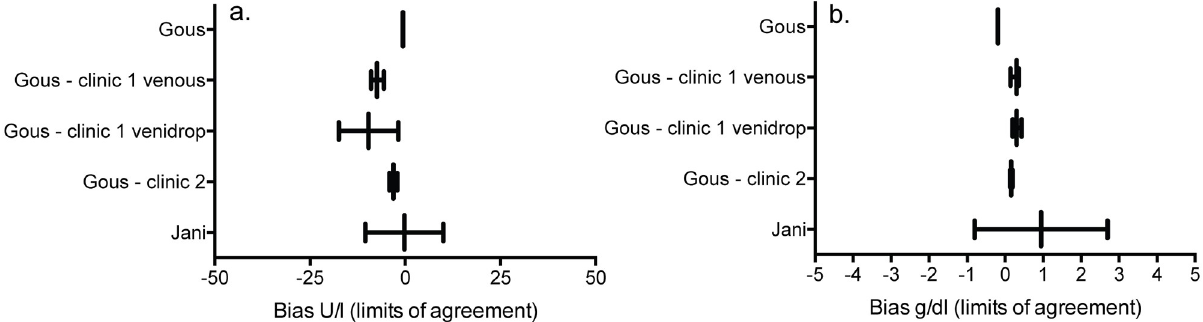
Fig 3. Forest plots of point-of-care ALT and hemoglobin diagnostic accuracy performance by non-laboratory staff. (a) point-of-care ALT testing by non-laboratory staff compared to conventional laboratory-based testing by professional laboratory staff; (b) point-of-care hemoglobin testing by non-laboratory staff compared to conventional laboratory-based testing by professional laboratory staff.